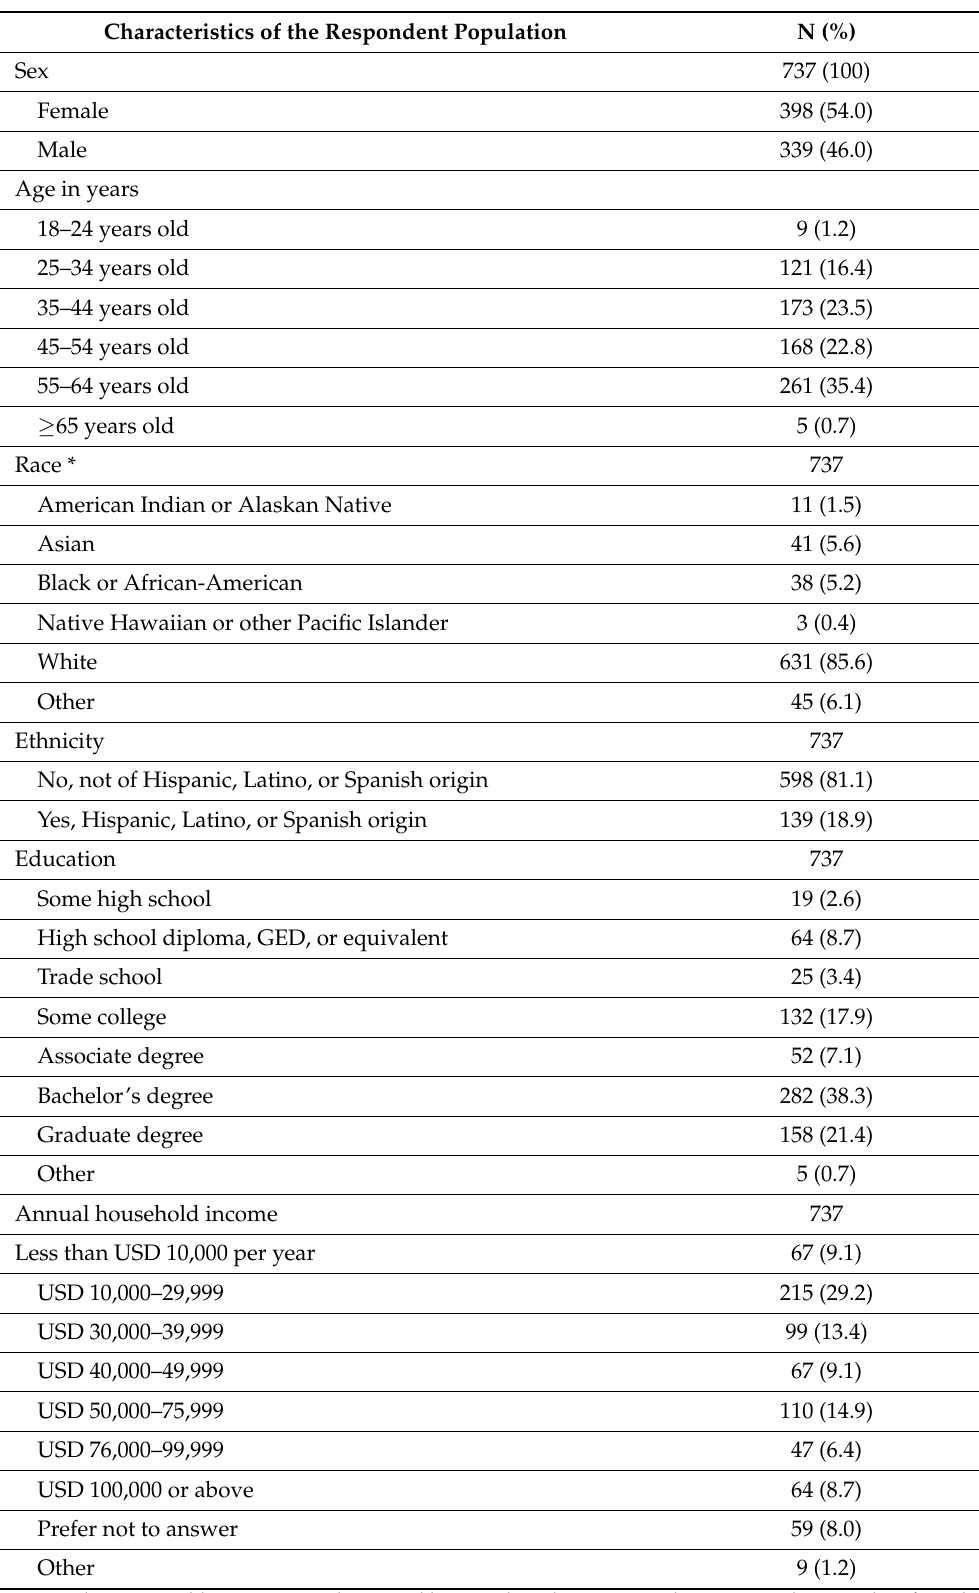
Table 1. Reported demographic and summary characteristics of the survey